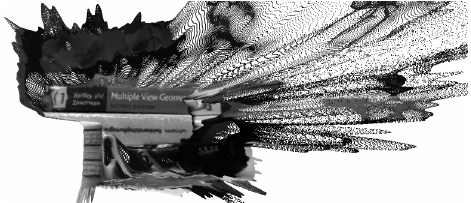
Figure 9. 3D metric point cloud of a sample scene (Fig. 7) calcu- lated based on our focused plenoptic camera